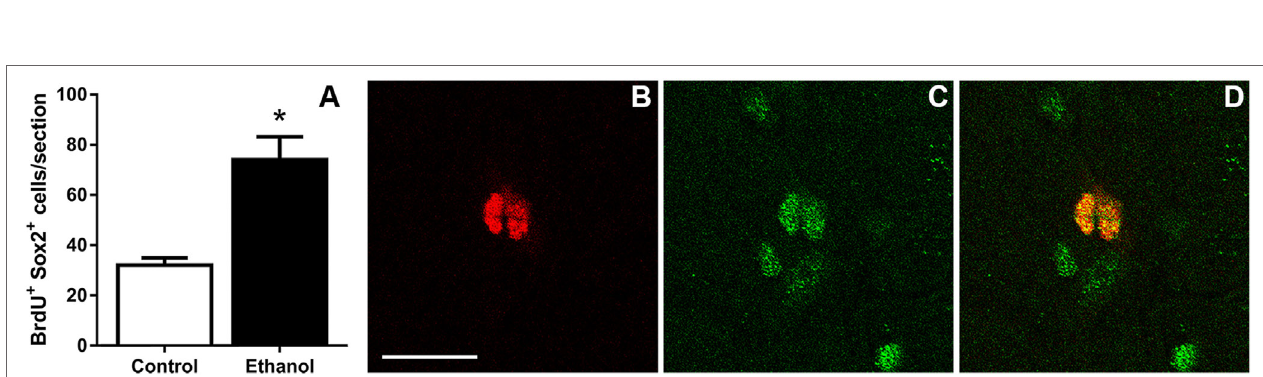
FigUre 3 | Binge ethanol exposure during adolescence increases the number of subgranular zone neural progenitor cells at day 7 of abstinence. (a) Quantification data of BrdU + and Sox2 + co-positive cells in control and alcohol rats. (B–D) Representative fluorescent images for BrdU [red (B) ] and Sox2 [green (c) ] and colabel (D) . Scale bars = 100 µm. * p <